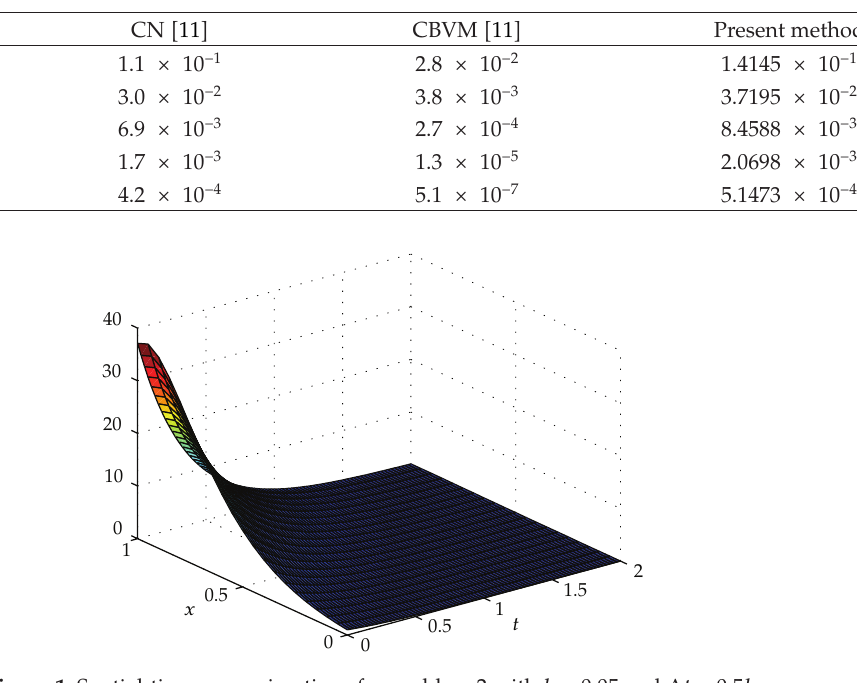
Table 2: Maximum absolute error obtained for problem 1.